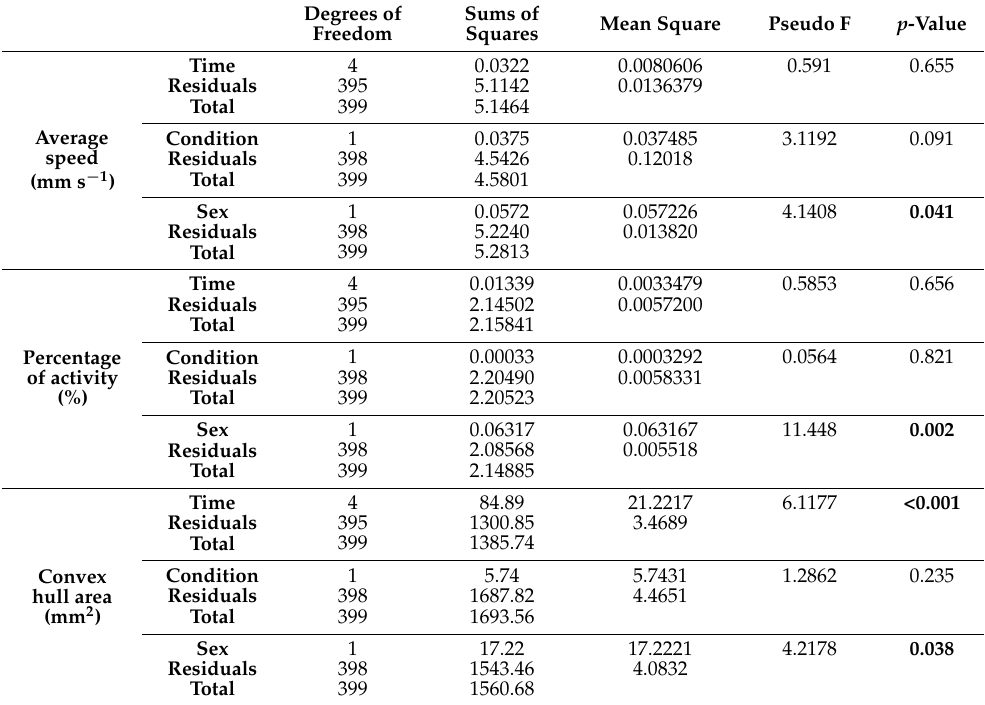
Table 2. PERMDISP analysis results for each factor of the studied trajectory parameters. Significant results in bold.